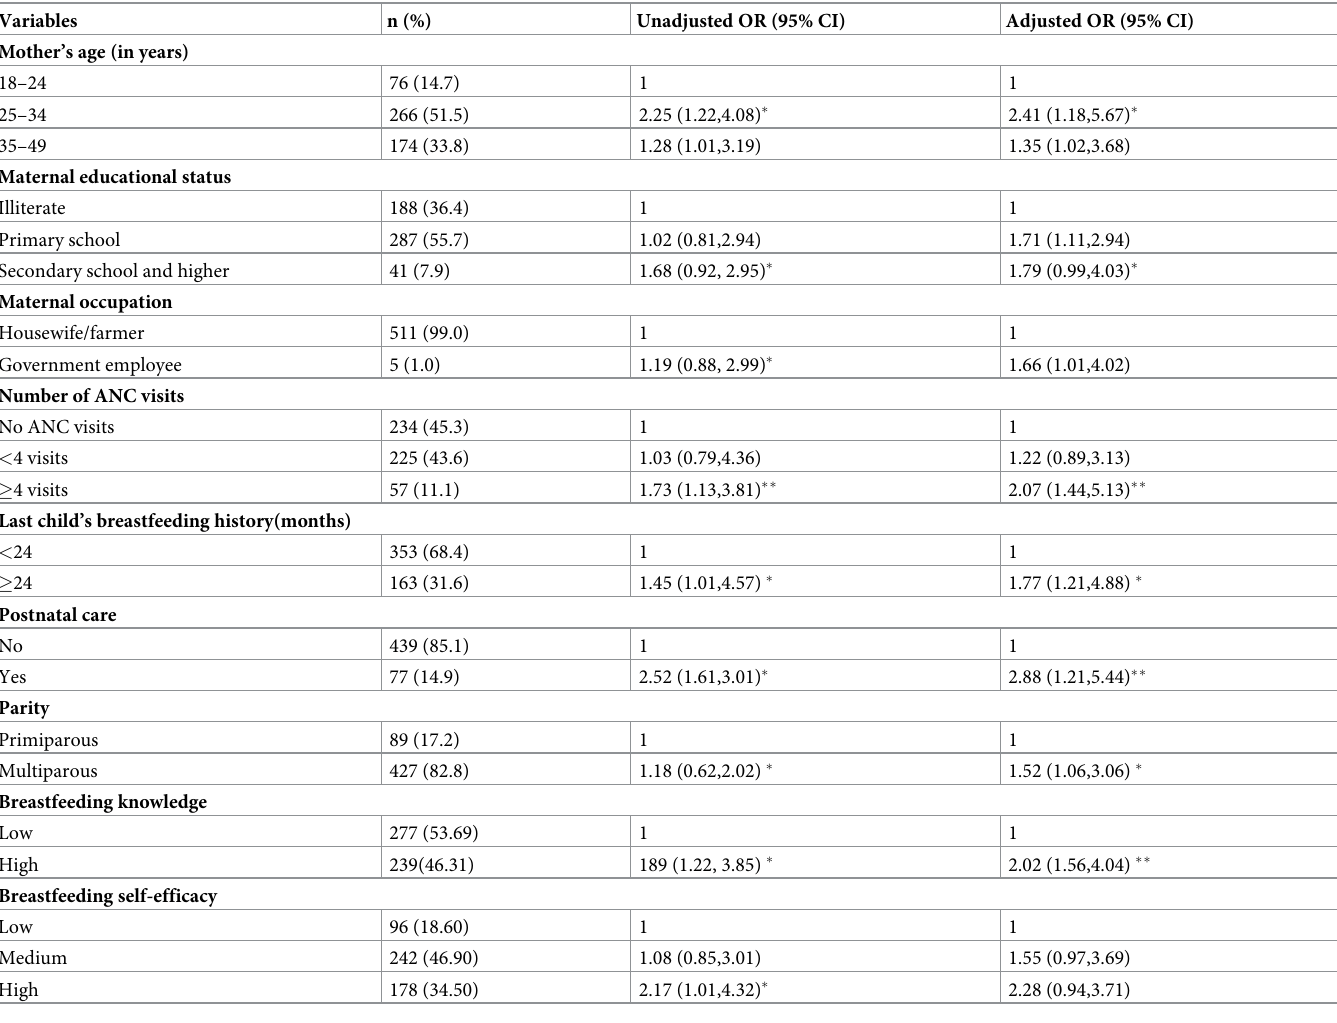
Table 4. Association between breastfeeding attitudes and their